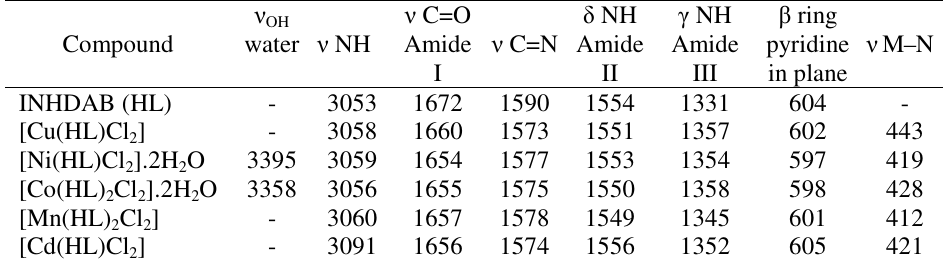
Table 2. Characteristic IR bands (cm -1 ) of the INHDAB ligand and its